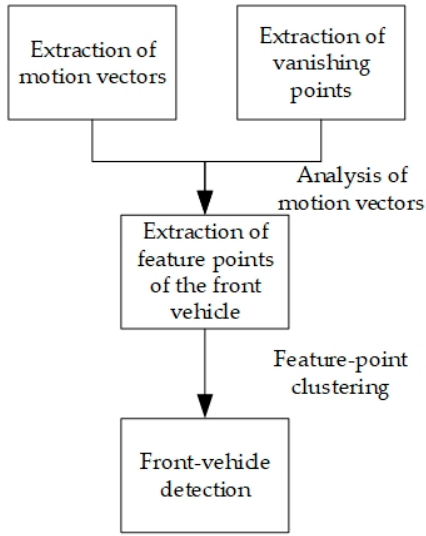
Figure 2. Flow of front-vehicle detection based on clustering of temporal and spatial characteristics.